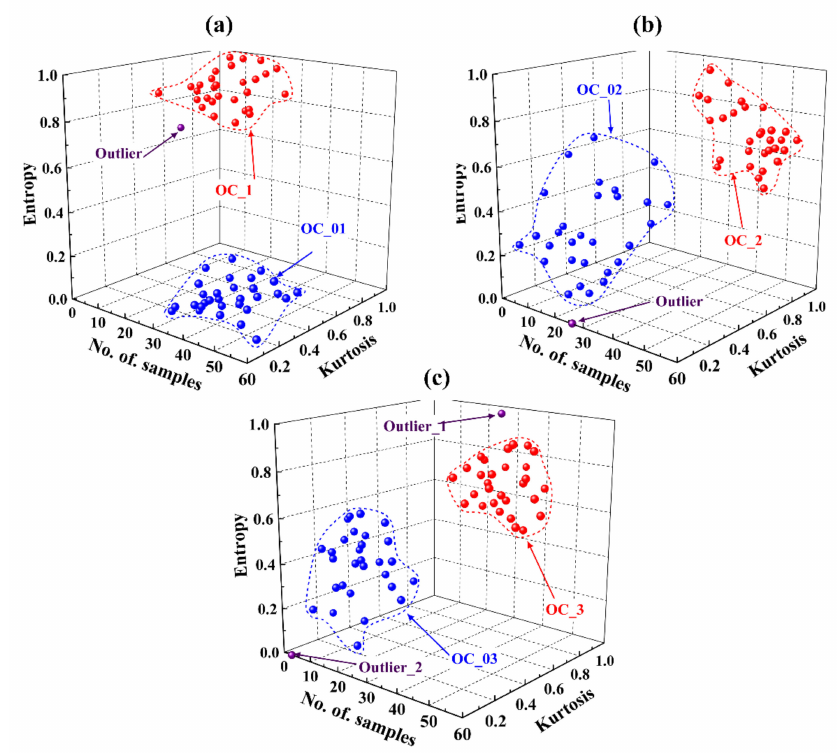
Figure 16. The optimal clustering results under each load condition: ( a ) light load (OC_1, OC_01), ( b ) medium load (OC_2, OC_02), overload ( c ) (OC_3,